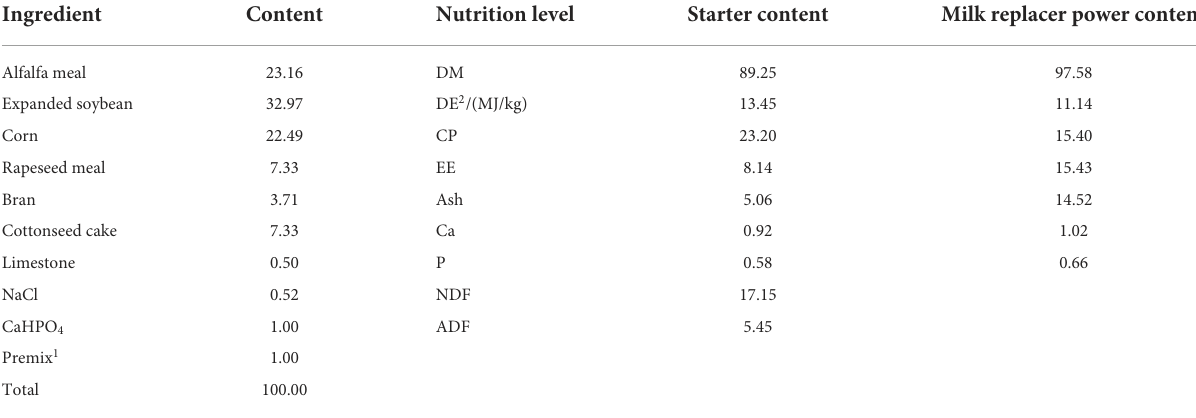
TABLE 1 Composition and nutrient composition of the starter (dry matter basis)